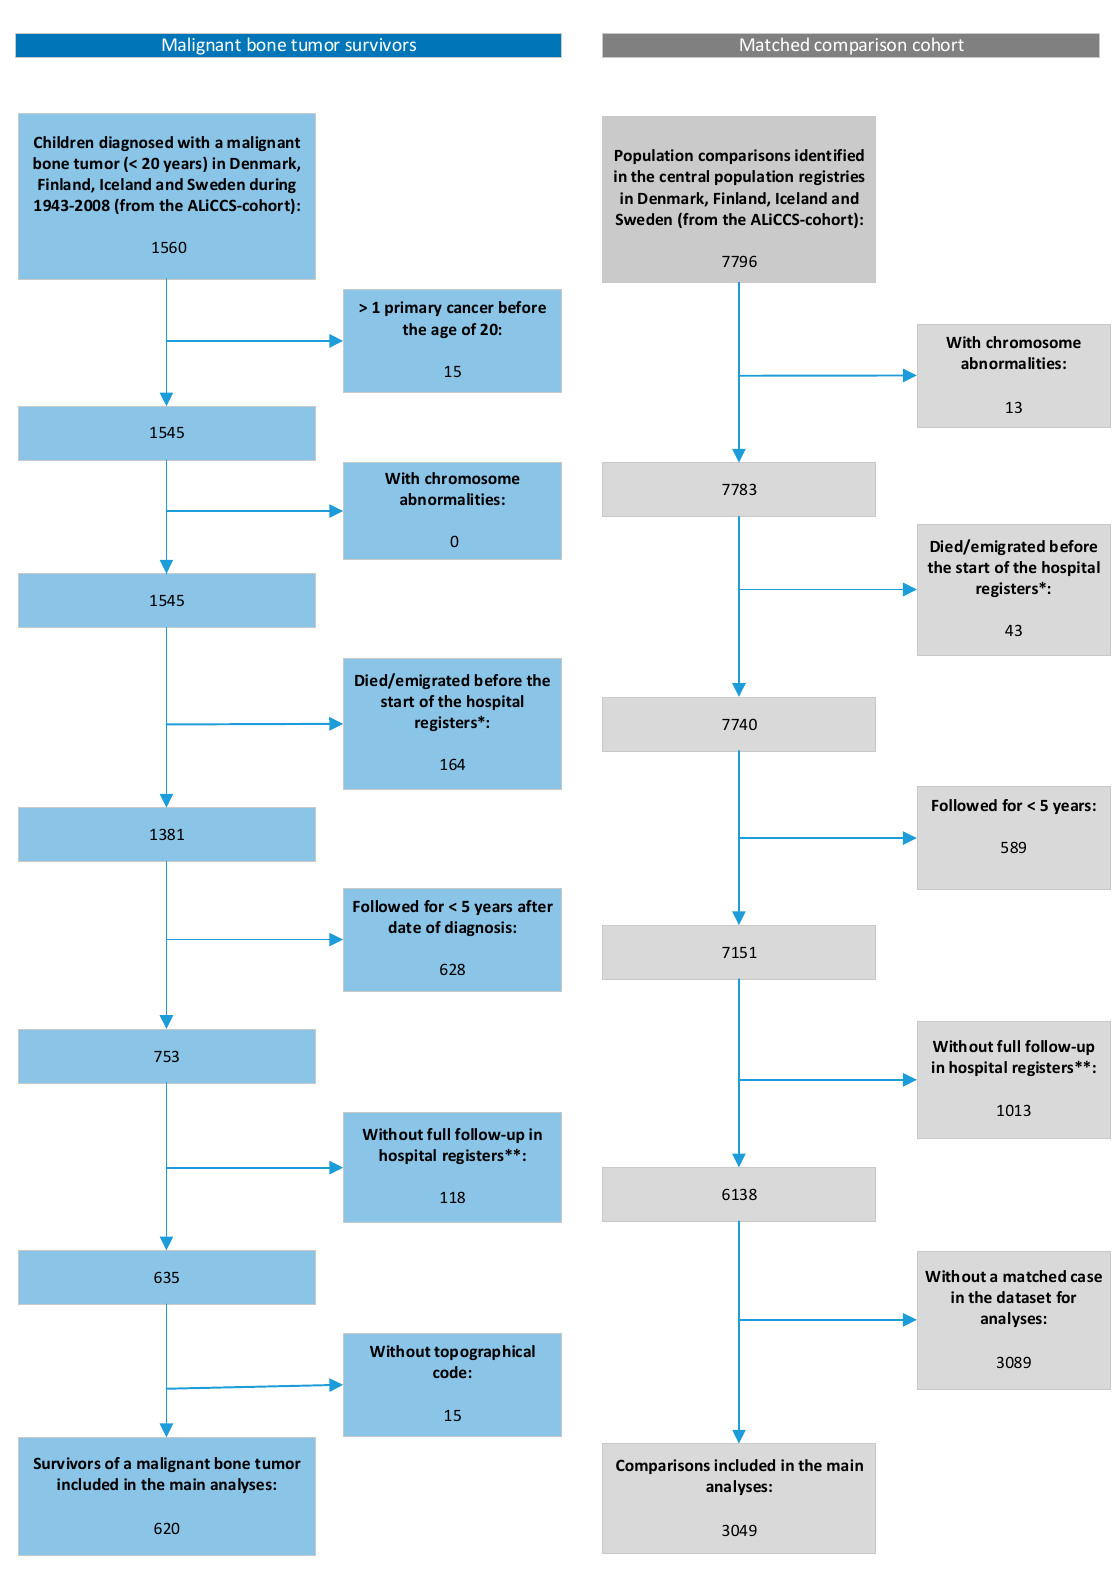
Figure 1. Flow diagram showing exclusions from the cohort of malignant bone tumor survivors and the matched compar- isons cohort. * Information on inpatient admissions was available from the start of the hospital registers (Denmark, 1977; Finland, 1983; Iceland, 1999; Sweden, 1968), and outpatient visits were available for Denmark from 1995 and for Sweden from 2001. ** Individuals diagnosed more than 5 years before the start of the hospital registers were excluded to avoid a gap in information on the history of hospital contacts and to ensure accurate rates of hospital contacts.